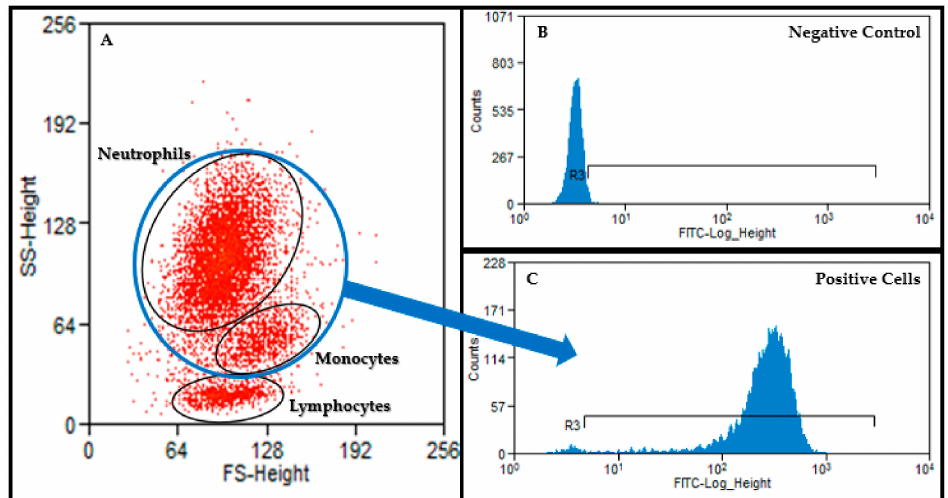
Figure 4. A forward versus side scatter plot ( A ) was used to gate neutrophils and monocytes. This gate was then applied to the appropriate histogram to identify FITC negative ( B ) and positive cells (( C ); neutrophils and